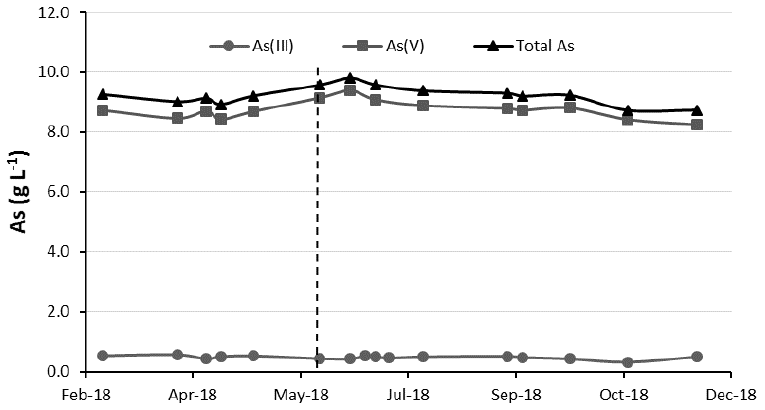
Figure 1. Trend of As species and total As concentration in copper electrolyte for 2018. Dashed line indicates the start of the industrial Sb/Bi removal plant.